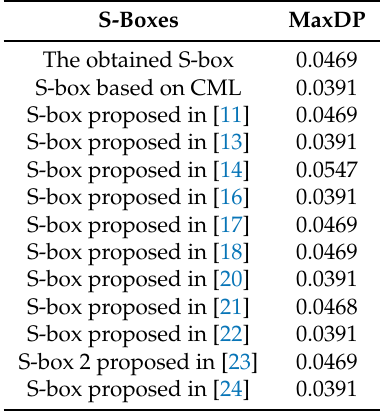
Table 10. The maximum differential probability (DP) analysis of different